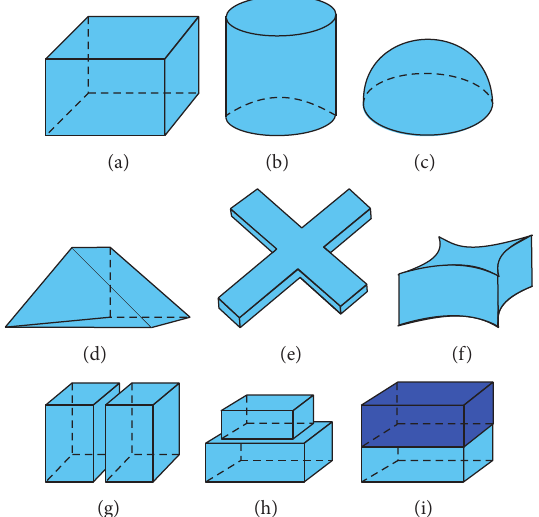
Figure 1: Different radiating structures used for dielectric resonator antennas